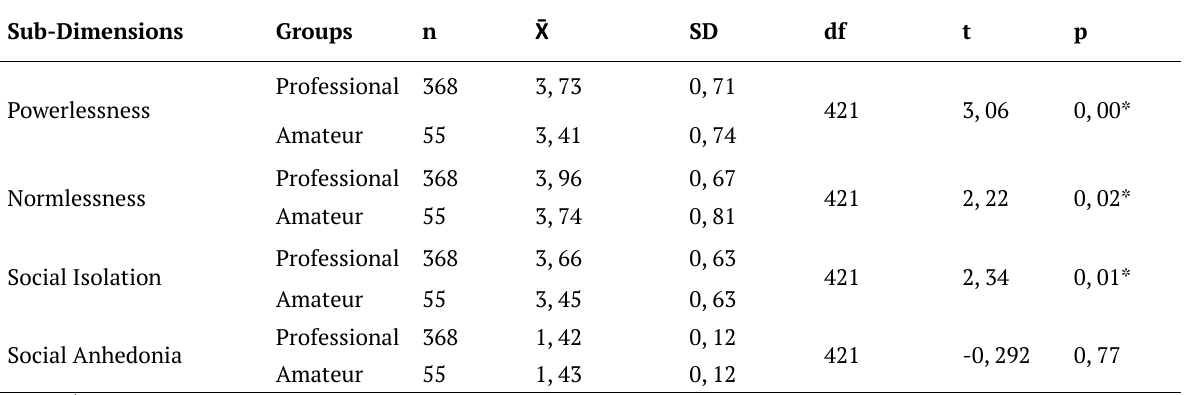
p<0.05. Table 5. The differences between the sub-dimensions of RSAS and DAS according to the sports category of the students Sub-Dimensions